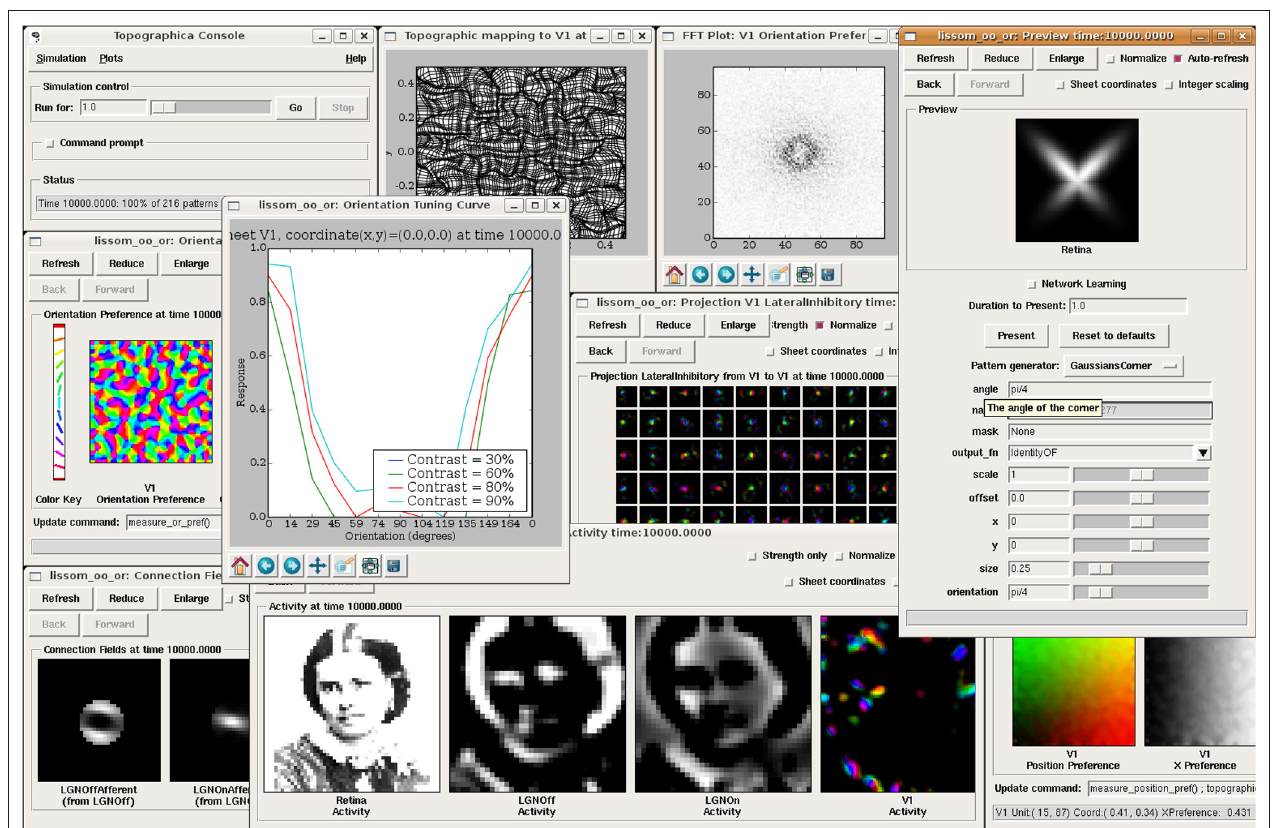
dialog at the right. The window labeled “Connection Fields” shows the strengths of the connections to one neuron in V1. The lateral weights for a 9 × 9 sampling of the V1 neurons are shown in the “Weights Array” window in the center; neurons tend to connect to their immediate neighbors and to distant neurons of the same orientation. The “Topographic Mapping” window shows how retinotopy has been distorted by the orientation map, and the “FFT Plot” shows that the orientation map repeats regularly in all dimensions, as in animals. This type of large-scale analysis is diffi cult with other simulators, but typically requires no new coding or software development once a network simulation has a basic connection to